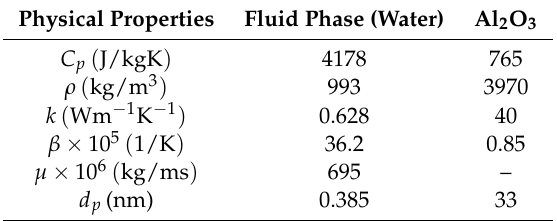
Table 1. Thermophysical properties of the Al 2 O 3 -water at T = 310 K